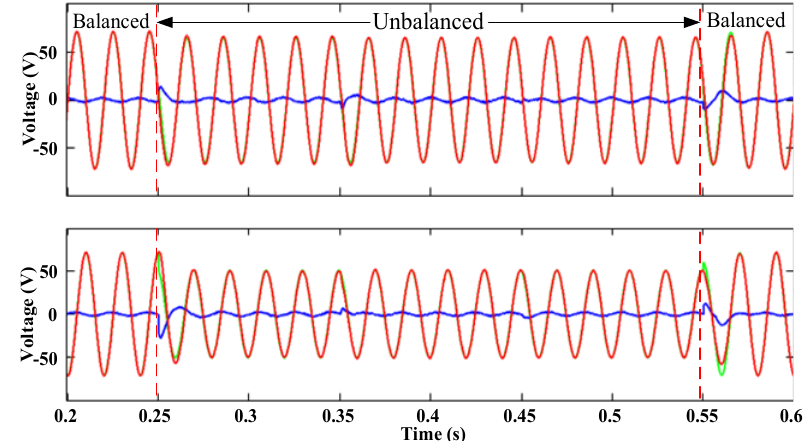
Figure 4. Simulated comparisons between measurements and estimations for the grid voltage in the αβ reference system (red—measurements, green—estimations, blue—errors).